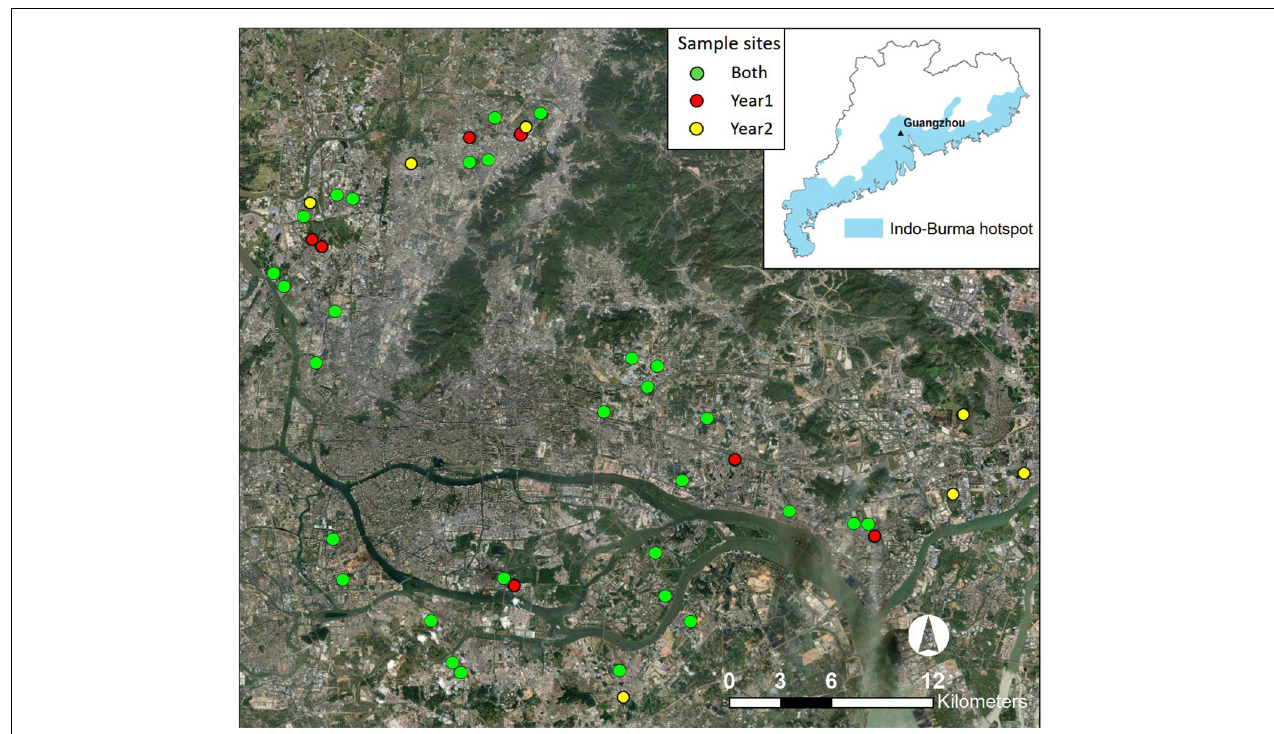
FIGURE 1 | Location of study region (Guangzhou inset map) and urban farmlands (closed circles) sampled. Years 1, 2 represent study sites surveyed in the first winter and in the second winter, respectively. Both indicates farmlands surveyed in the first and second